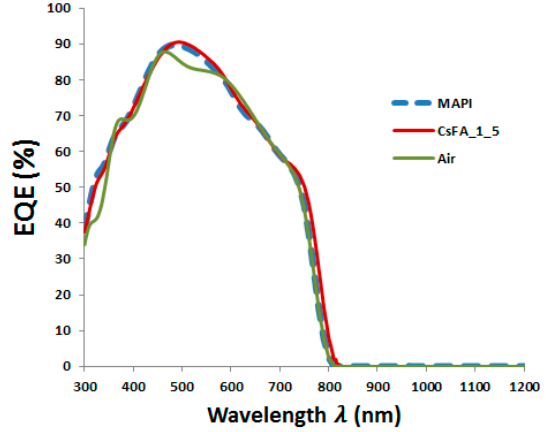
Figure 6. Simulated external quantum efficiency (EQE) solar cells based on MAPbI 3 and CsFAPbIBr perovskites.